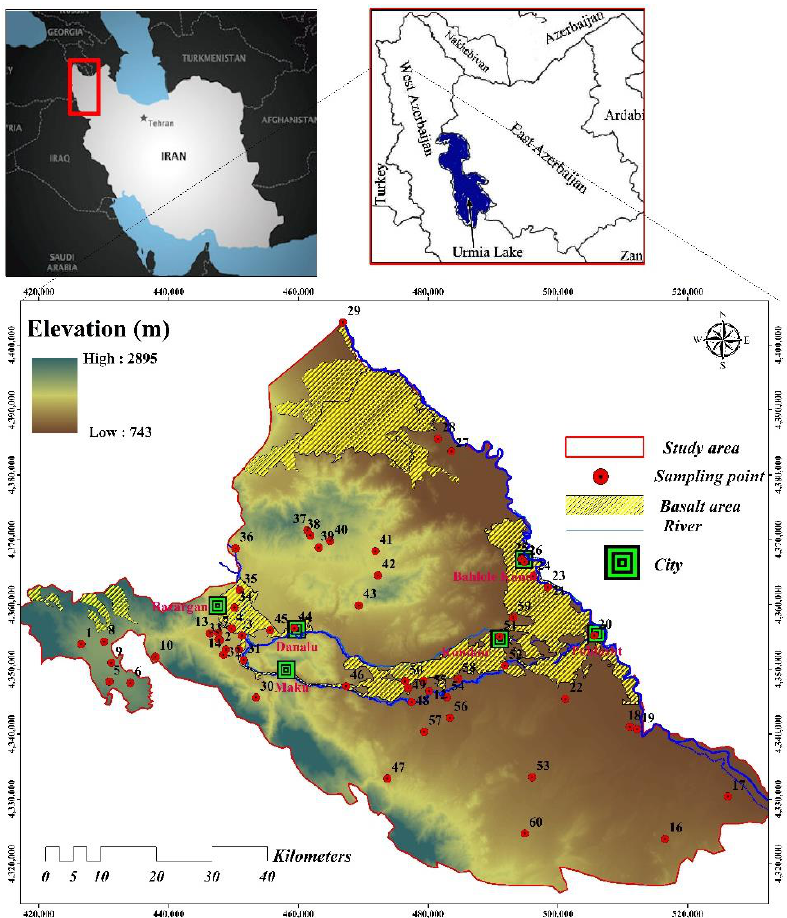
Figure 2. Situation map of the Maku–Bazargan–Poldasht area, drainage system, and sampling locations.